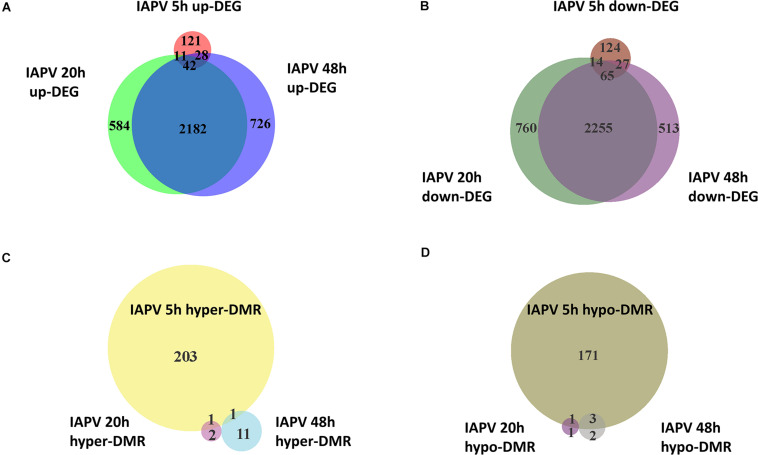
Directional overlap of differentially regulated genes among time points. (A) Venn diagram showing genes that were differentially expressed as up-regulated (FDR < 0.05). Number of DEGs only in post IAPV 5, 20, and 48 h are 121, 584, and 726. Number of genes between IAPV 5 and 20 h only overlap is 11. Number of DEGs between IAPV 5 and 48 h only overlap is 28. Number of DEGs between IAPV 20 and 48 h only overlap is 2182. Number of DEGs from IAPV 5–20–48 h overlap is 42. (B) Venn diagram showing genes that are differentially expressed as down-regulated (FDR < 0.05). Number of DEGs only in post IAPV 5, 20, and 48 h are 124, 760, and 513. Number of DEGs between IAPV 5 and 20 h only overlap is 14. Number of DEGs between IAPV 5 and 48 h only overlap is 27. Number of DEGs between IAPV 20 and 48 h only overlap is 2255. Number of DEGs from IAPV 5–20–48 h overlap is 65. (C) Venn diagram showing genes that are differentially methylated (percent methylation difference larger than 10%, q < 0.01) as hyper-methylation among three time points (5, 20, and 48 h after IAPV infection). Number of DMRs only in post IAPV 5, 20, and 48 h are 203, 2, and 11. Number of DMRs between IAPV 5 and 20 h only overlap is 1. Number of DMRs between IAPV 5 and 48 h only overlap is 1. (D) Venn diagram showing genes that are differentially methylated (percent methylation difference larger than 10%, q < 0.01) as hypo-methylation among three time points (5, 20, and 48 h after IAPV infection). Number of DMRs only in post IAPV 5, 20, and 48 h are 171, 1, and 2. Number of DMRs between IAPV 5 and 20 h only overlap is 1. Number of DMRs between IAPV 5 and 48 h only overlap is 3.